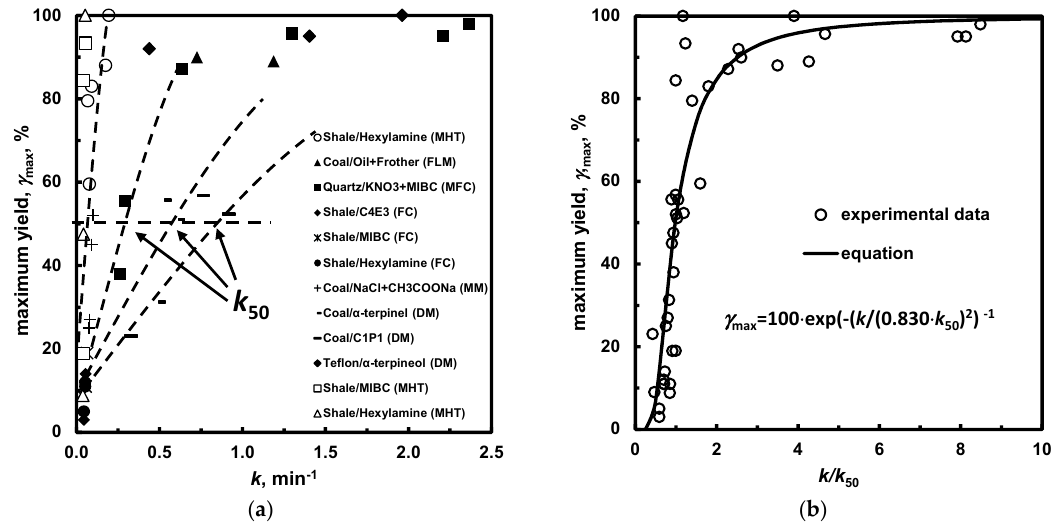
Figure 14. ( a ) Limits kinetic curves; and ( b ) universal limits kinetic curves after normalization against kinetic constant for maximum yield of 50% [67]. Table 14. Values k 50 for different separation systems. Symbols in the parenthesis denote the type of